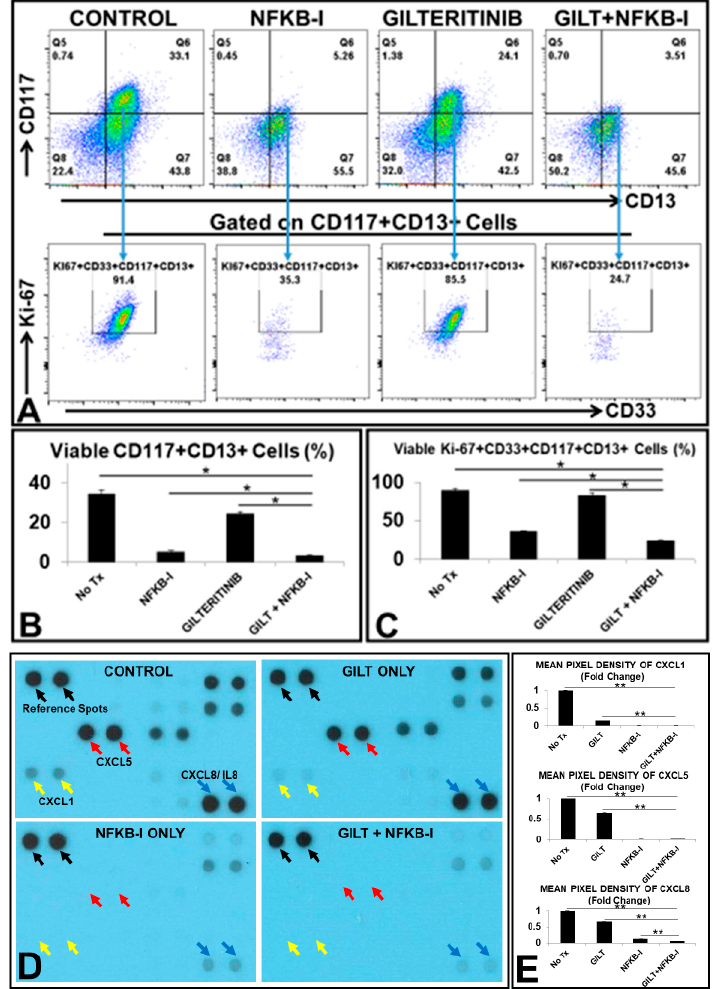
Figure 6. The therapeutic effect of the combination of 80 nM GILT and 50 uM NFKB-I on a newly diagnosed AML-FLT3 BMMNC (Patient #5) ex vivo. ( A ) Representative FC plots of viable CD117+CD13+ primary blasts in different treatment groups; Blue arrows (Gating) indicate further analyses of Ki-67 expression of these viable CD117+CD13+ primary blasts; ( B ) Cumulative FC percentage data of viable CD117+CD13+ primary blasts; ( C ) Cumulative FC percentage data of viable Ki-67+CD33+CD117+CD13+ primary blasts; ( D ) Image of partial blot films developed for proteomic analyses of cell-free supernatants from GILT-treated primary AML BMMNC cells. The black arrows indicate the control dots from the manufacturer. The yellow, red and blue arrows indicate the dots of CXCL1, CXL5 and CXCL8 respectively in the film. ( E ) Cumulative Mean Pixel Densities (Fold Change) of CXCL1, CXCL5, CXCL8. * p < 0.05, ** p <